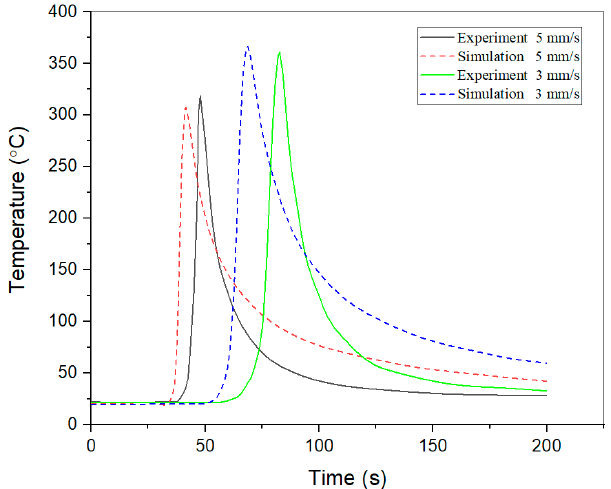
Figure 4. Comparison results of thermal cycling curves at different welding speeds obtained by simulation and experiment.